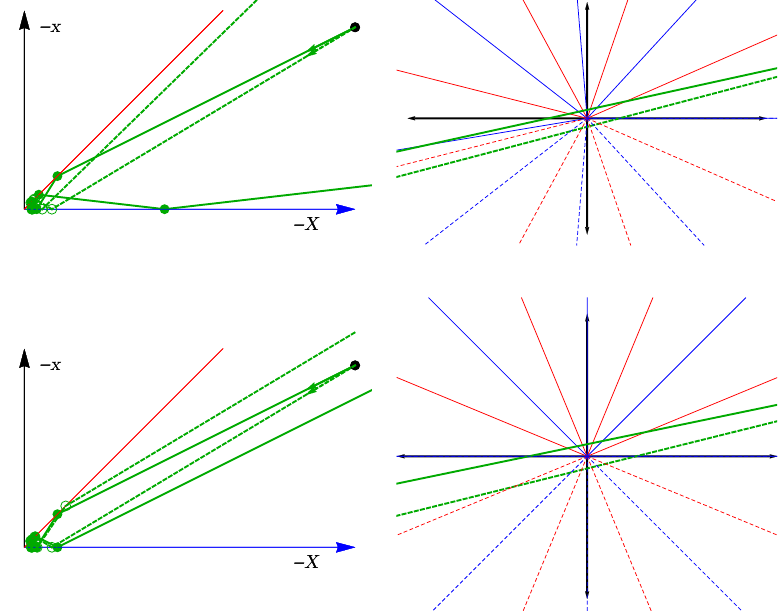
Figure 11. Each horizontal pair of figures depicts two trajectories (in green) that start at the same point in configuration space but have slightly different velocities in configuration space (left) and unfolded billiard coordinates (right). For the solid green lines, the initial velocities determine that the first collision is a ball–ball collision (red line), and for the dashed lines the first collision is ball–wall (blue line). The top row depicts a generic mass ratio β = π /7.6. From the configuration space trajectory in the top left, we see that for the generic case, slightly different initial conditions can lead to very different final velocities and a different number of collisions. The figure at the top right explains this by showing that the two nearby trajectories induce inequivalent unfoldings; the solid red and blue lines are the unfolded collision lines for the trajectory with ball–ball as first collision and the dashed red and blue lines for the trajectory with ball–wall as first collision. In this figure, the slightly different initial velocities lead to unfolded trajectories that diverge slowly and linearly in time, but the inequivalent unfoldings make their projections back to configuration space coordinates very different. In contrast, for the superintegrable case β = π /8 depicted in the bottom row, the solid and dashed unfoldings align at π . The unfolded trajectories with only slightly different slopes therefore give only slightly different projections at the end. Note that the reversal of initial velocities (51) is evident in the lower left